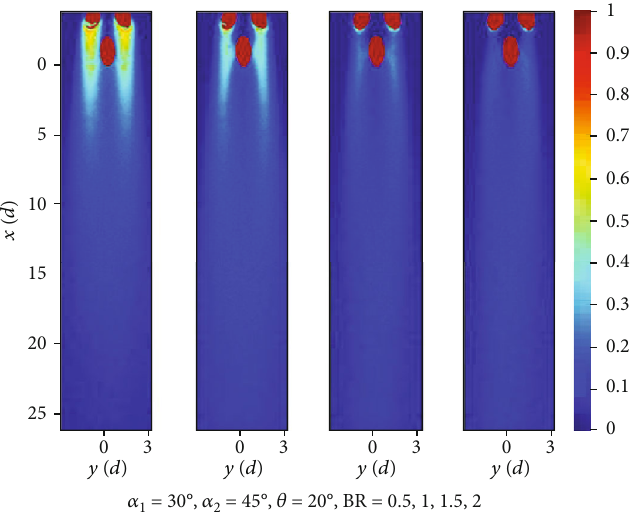
Figure 15: Film cooling e ff ectiveness distributions downstream of the branched holes, α